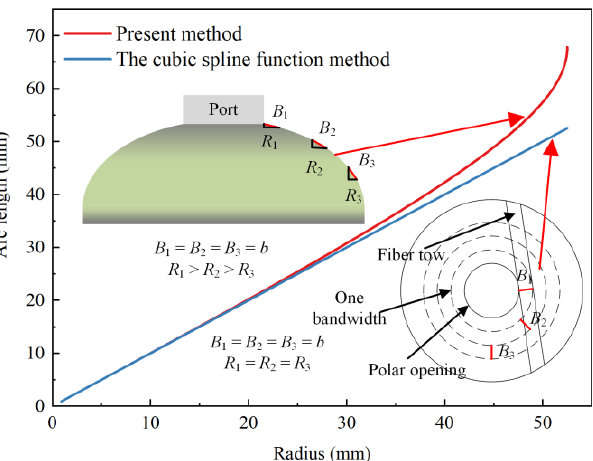
Figure 2. Comparison of analytical results of the arc length corresponding to the radius of parallel circle between two circle between two methods.